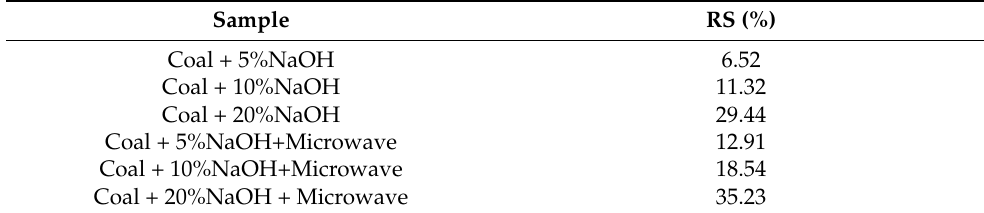
Table 2. Desulfurization rate of different